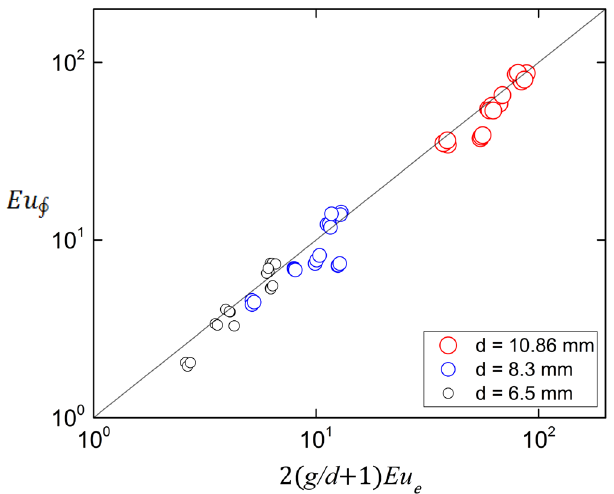
Figure 11. Balance of forces of the channel. The line corresponds to Eq. (20). The Pearson correlation coefficient is 0.97. Created with Gnuplot 5.4, www. gnupl ot.